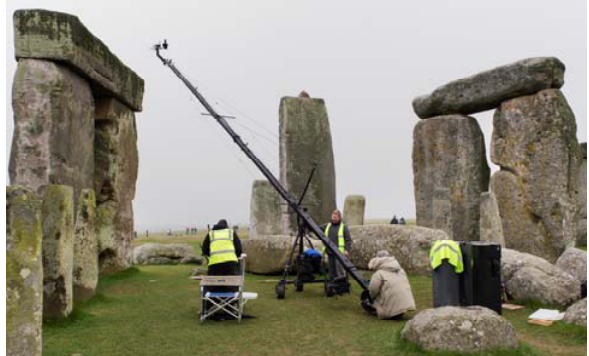
Figure 3 Use of ‘Jimmy Jib’ to capture stereo-photography of upper surfaces (Image by James Davies © English